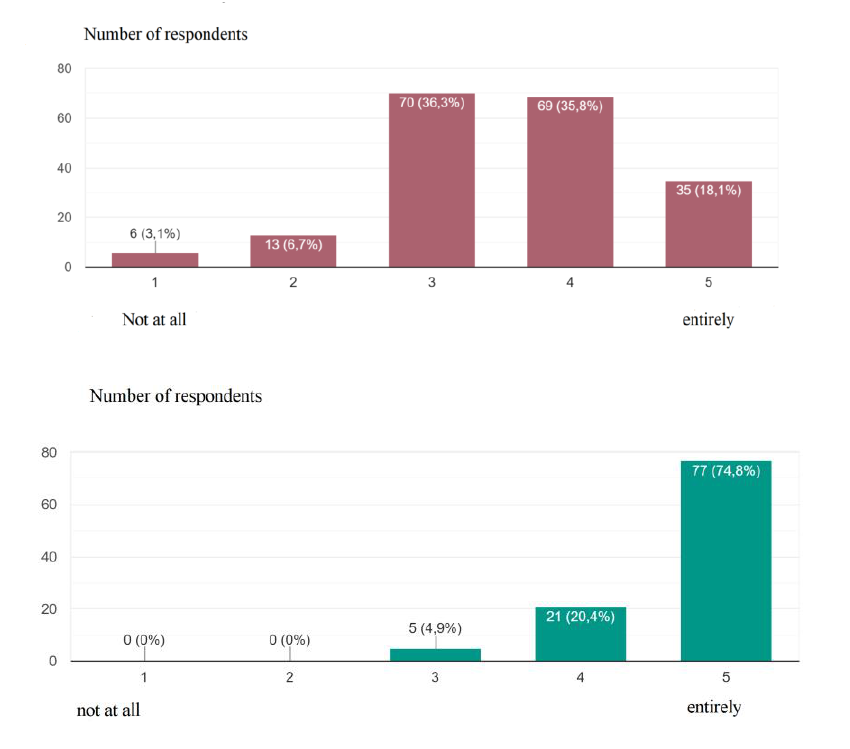
Fig. 1. Is it important for a student to have STEM